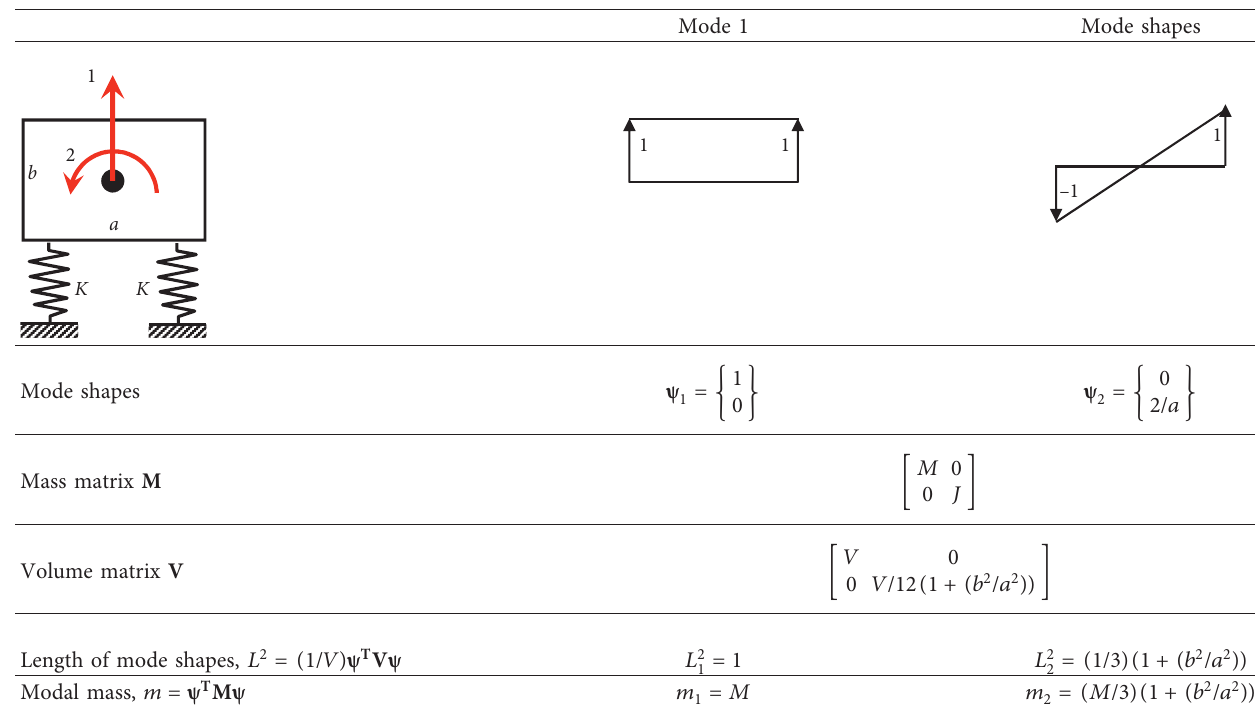
Table 5: A rigid block on springs. Discretization with one translation and one